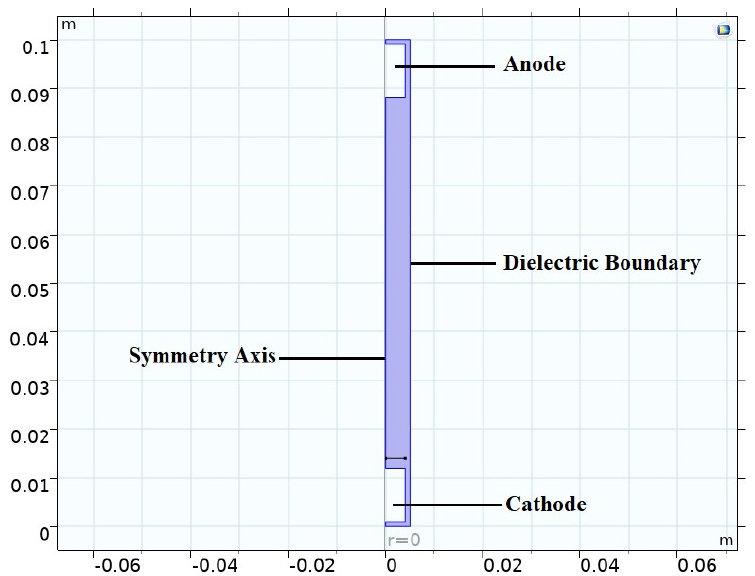
Figure 4. Schematic of plasma